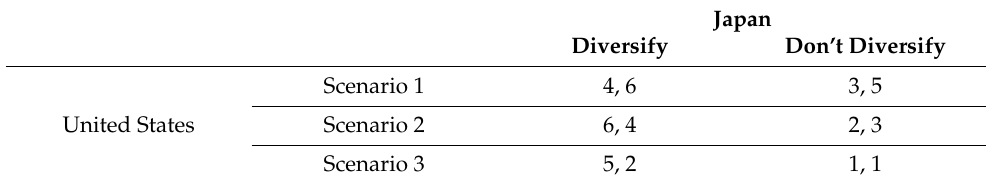
Table 6. Payoff matrix for sanction scenario 2 (Sanctioned Russia).